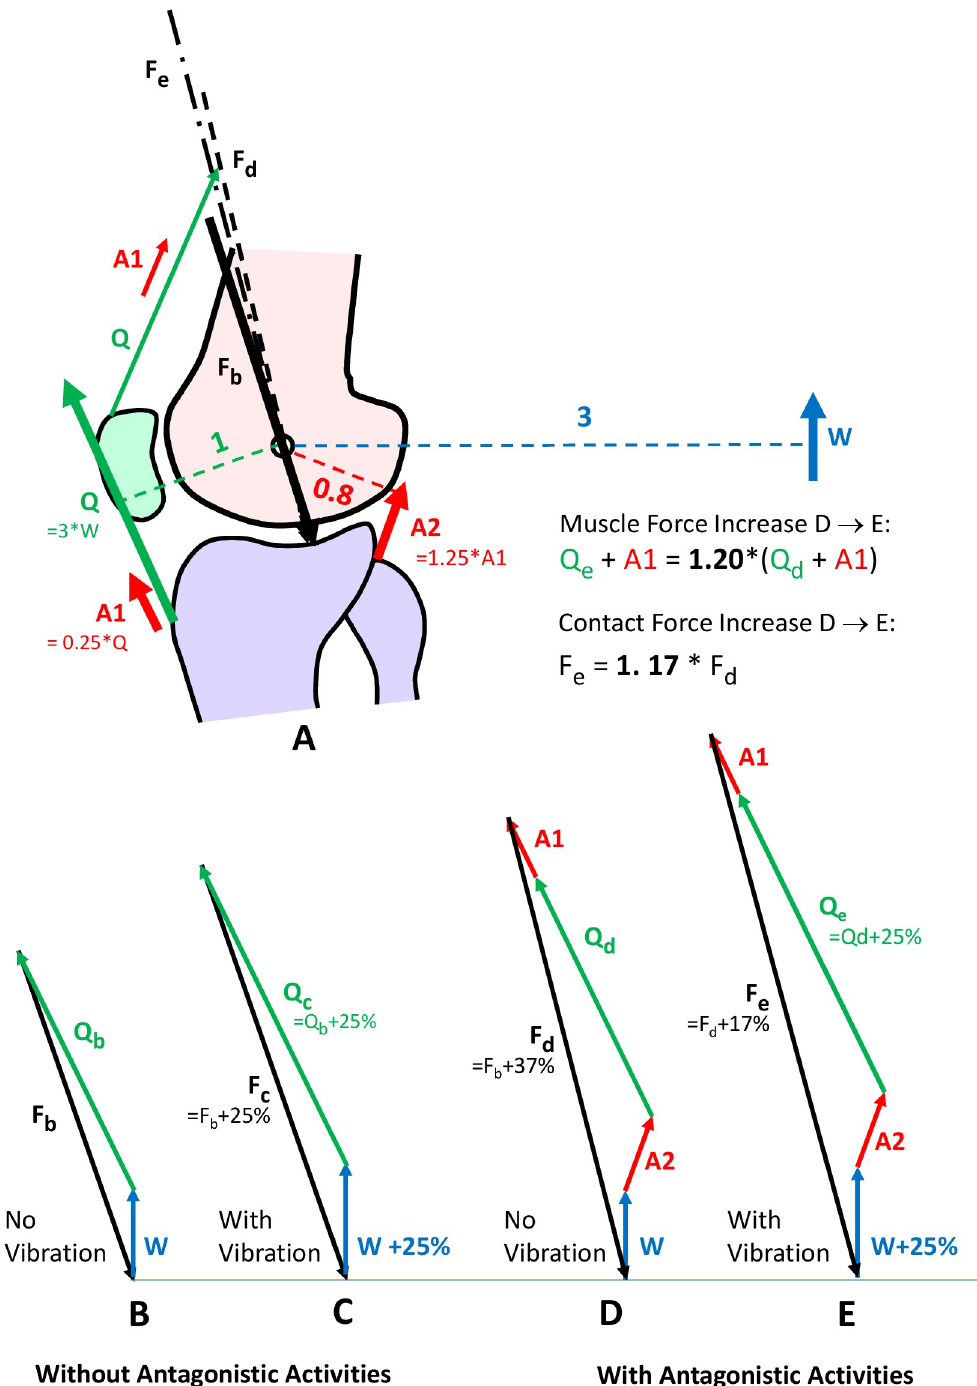
Fig 3. Simplified static knee model in the sagittal plane. (A) W = ground reaction force. Q = minimally required quadriceps force at tibia to balance W. F b to F e = joint contact forces. A1 = additional antagonistic component of Q, always assumed to be 25% of Q. A2 = antagonist of A1. (B) No antagonistic activities. (C) Like B, but W was increased by 25%, simulating vibrations. (D) With antagonistic forces A1 and A2. (E) Like D, but W was increased by 25%.